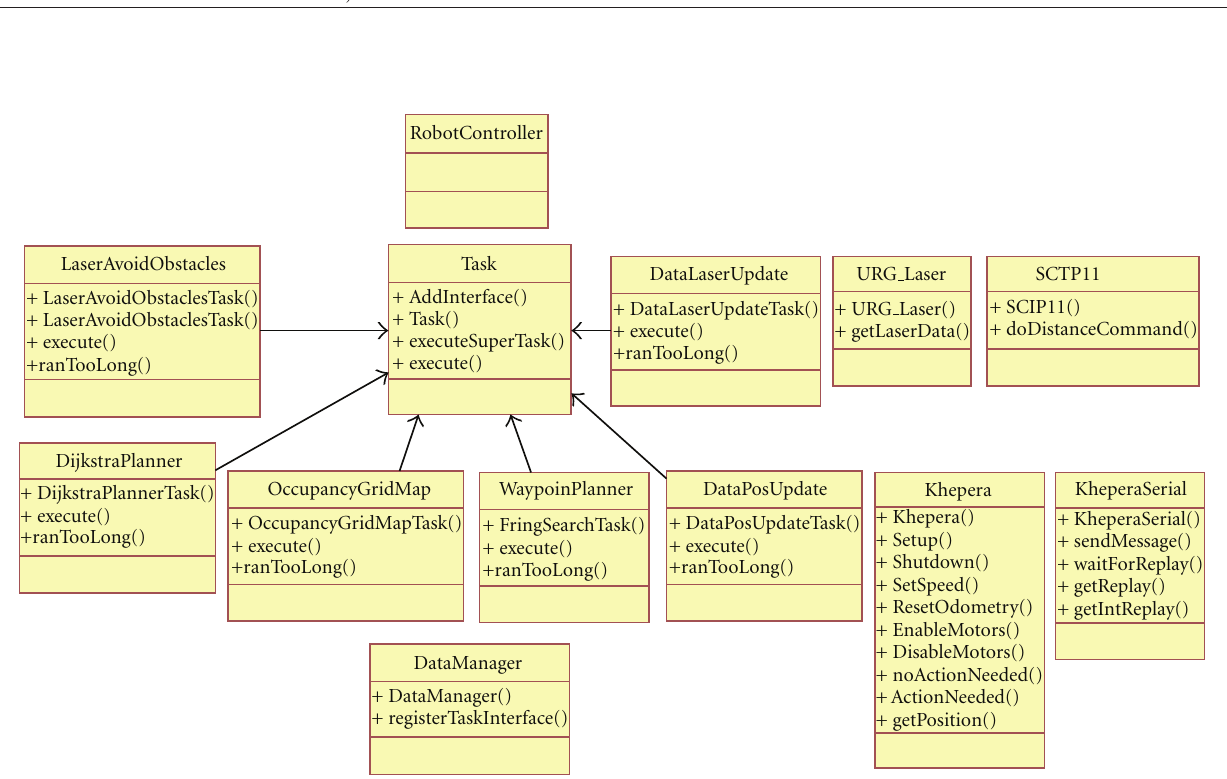
Figure 2: Class diagram of the essential parts of the